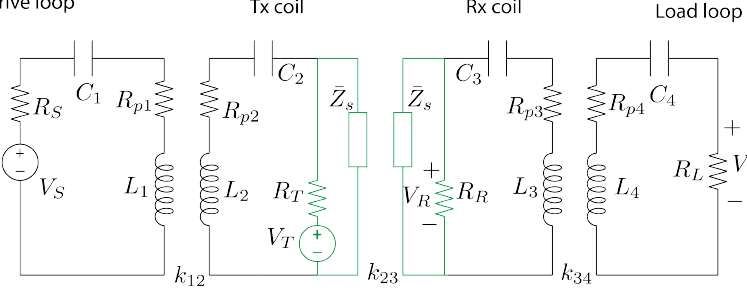
Figure 3. Data from the inner coils, with the inclusion of the series